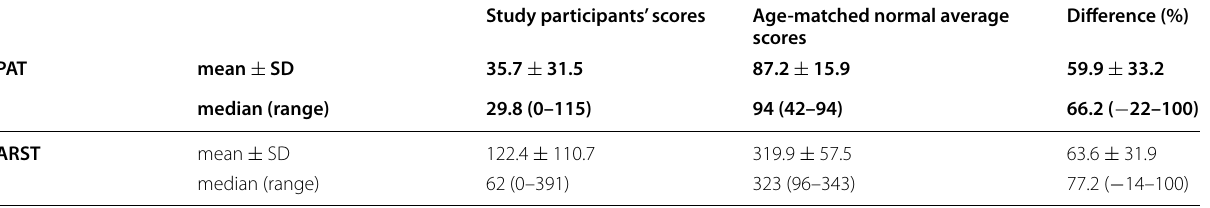
Table 4 The difference between participants’ PAT and ARST total average scores and their age-matched normal average scores